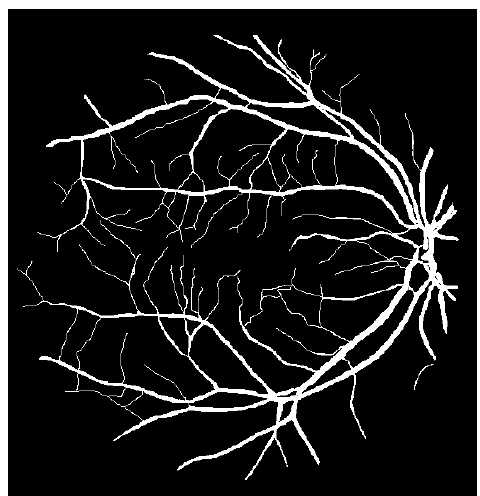
Figure 4. Retinal vessels of Figure 2.